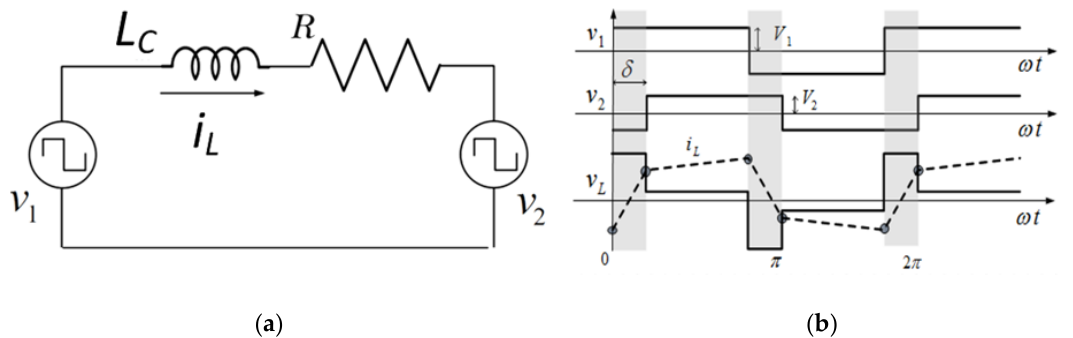
Figure 5. Dual-active bridge (DAB) basic equivalent state-space average model ( a ), and characteristic voltage and current waveforms illustrating the control principle ( b ).